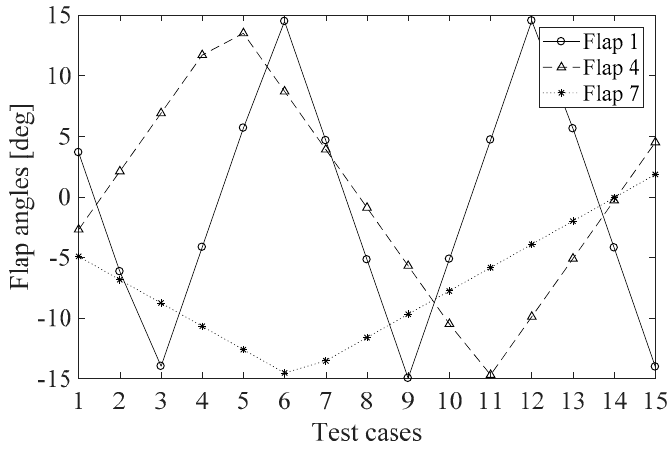
Figure 6. Examples of flap angles for “random” test cases. Table 5. Flap angle combination for “controlled” test cases.